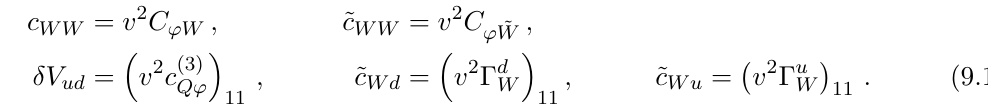
Figure 15 . Di(cid:11)erence of left and right-handed polarizations of the W + boson in W + H production p as a function of p W , at S = 14 T cut